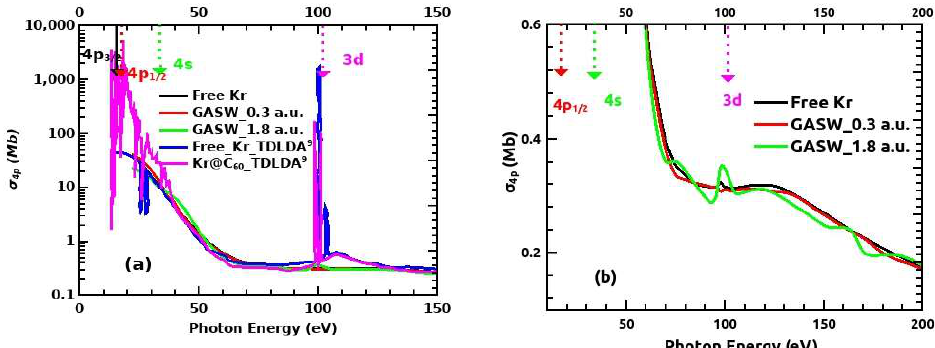
Figure 7. Photoionization cross-sections of the 4p orbital of free and confined Kr using the RRPA are compared with the TDLDA [9] results in (a) ( left panel ). A magnified view of the result is presented in (b) ( right panel) . Vertical arrows indicate the threshold values of the corresponding subshells used in the RRPA.